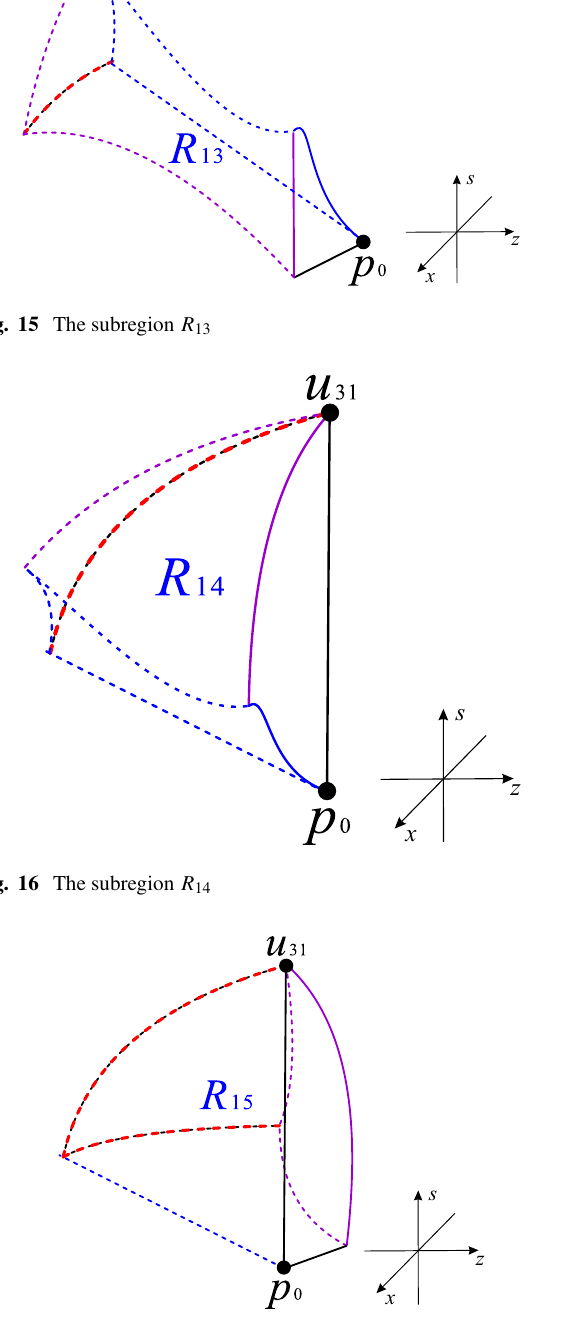
Fig. 18 The subregion R 16